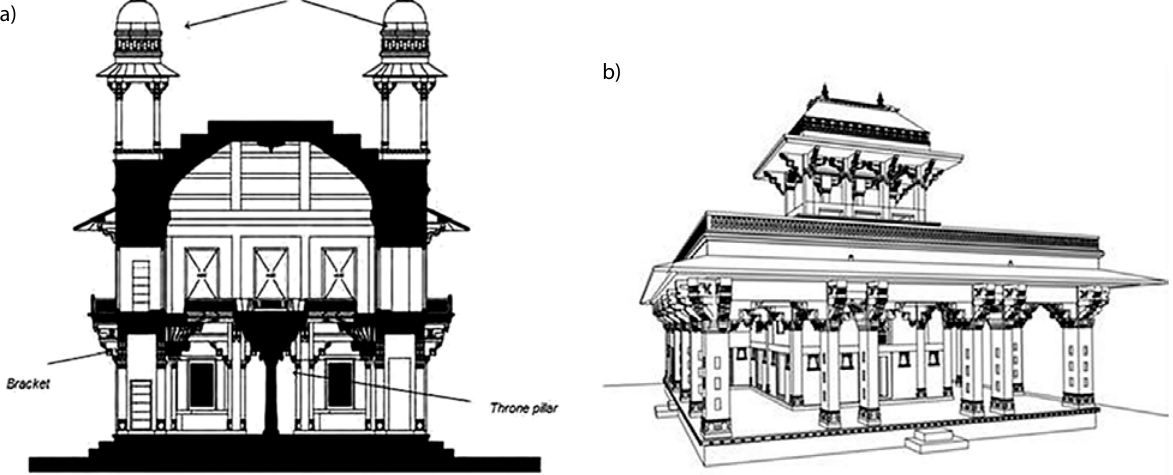
fig. 2. (a) The parasol-like Chattri of Diwani Khas, and (b) the overhanging pavillion of the Maryam house of fatehpur Sikri. In both structures, the “overhanging” and parasol-like elements served to harmonize with the proportions of overall structure and also help these buildings to be seen from afar (Shaukat et